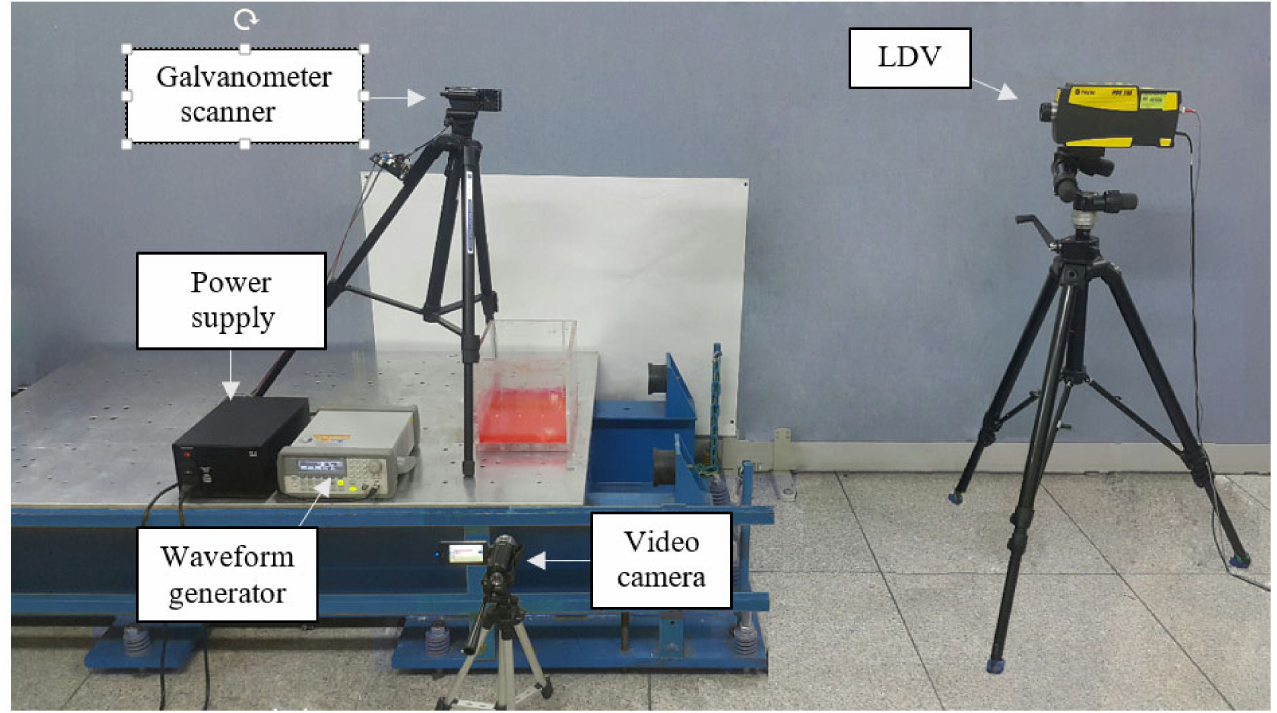
Figure 6. Experimental setup of the proposed wave scanning system.